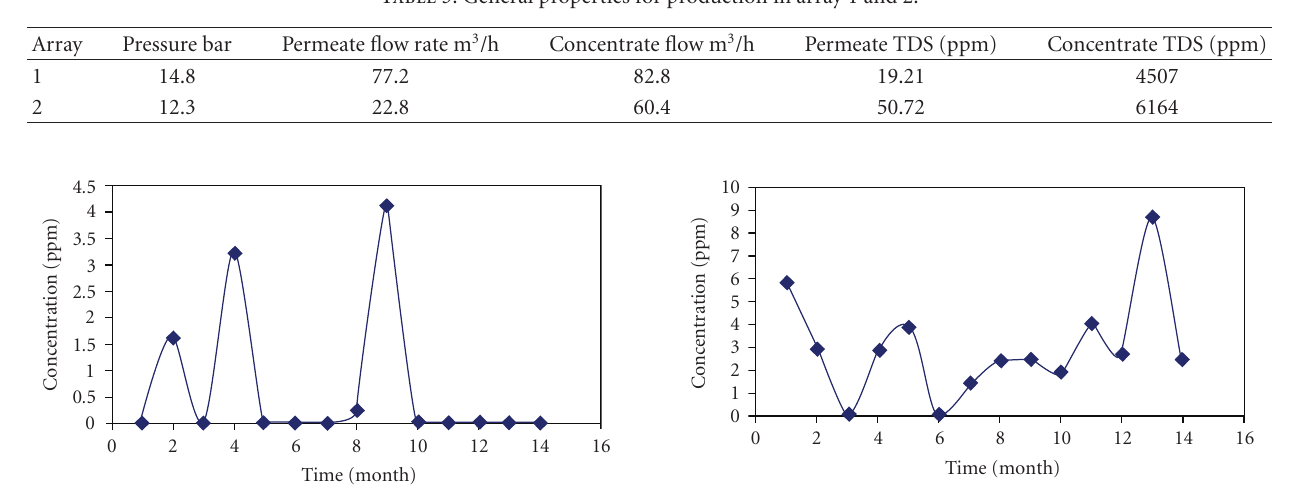
Table 3: General properties for production in array 1 and 2.